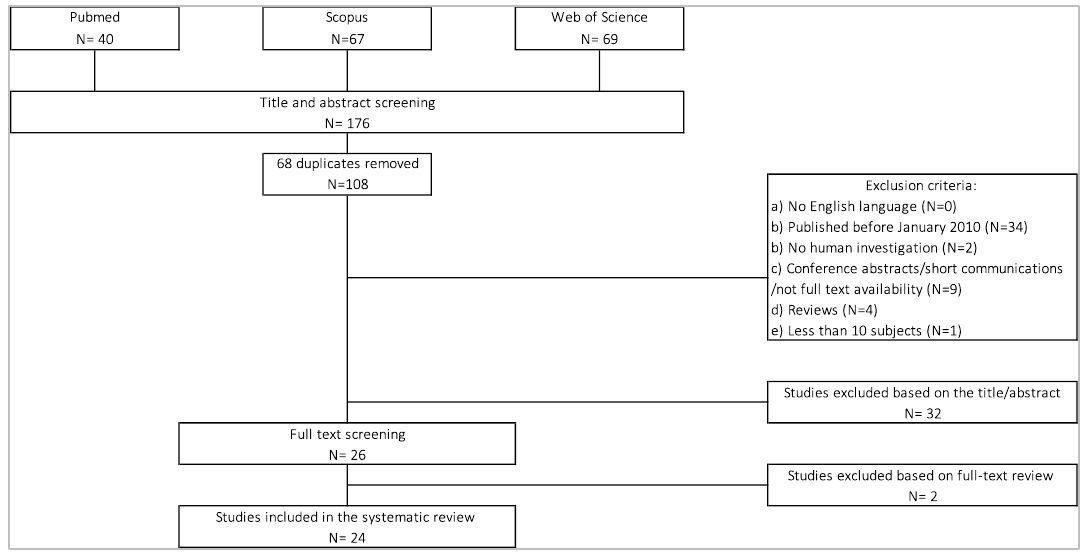
Figure 1. PRISMA (Preferred Reporting Items for Systematic Reviews and Meta-Analyses) flowchart for peripheral neuropathy (PNP) and wearable technology assessment. Sensors 2020 , 20 , x FOR PEER REVIEW